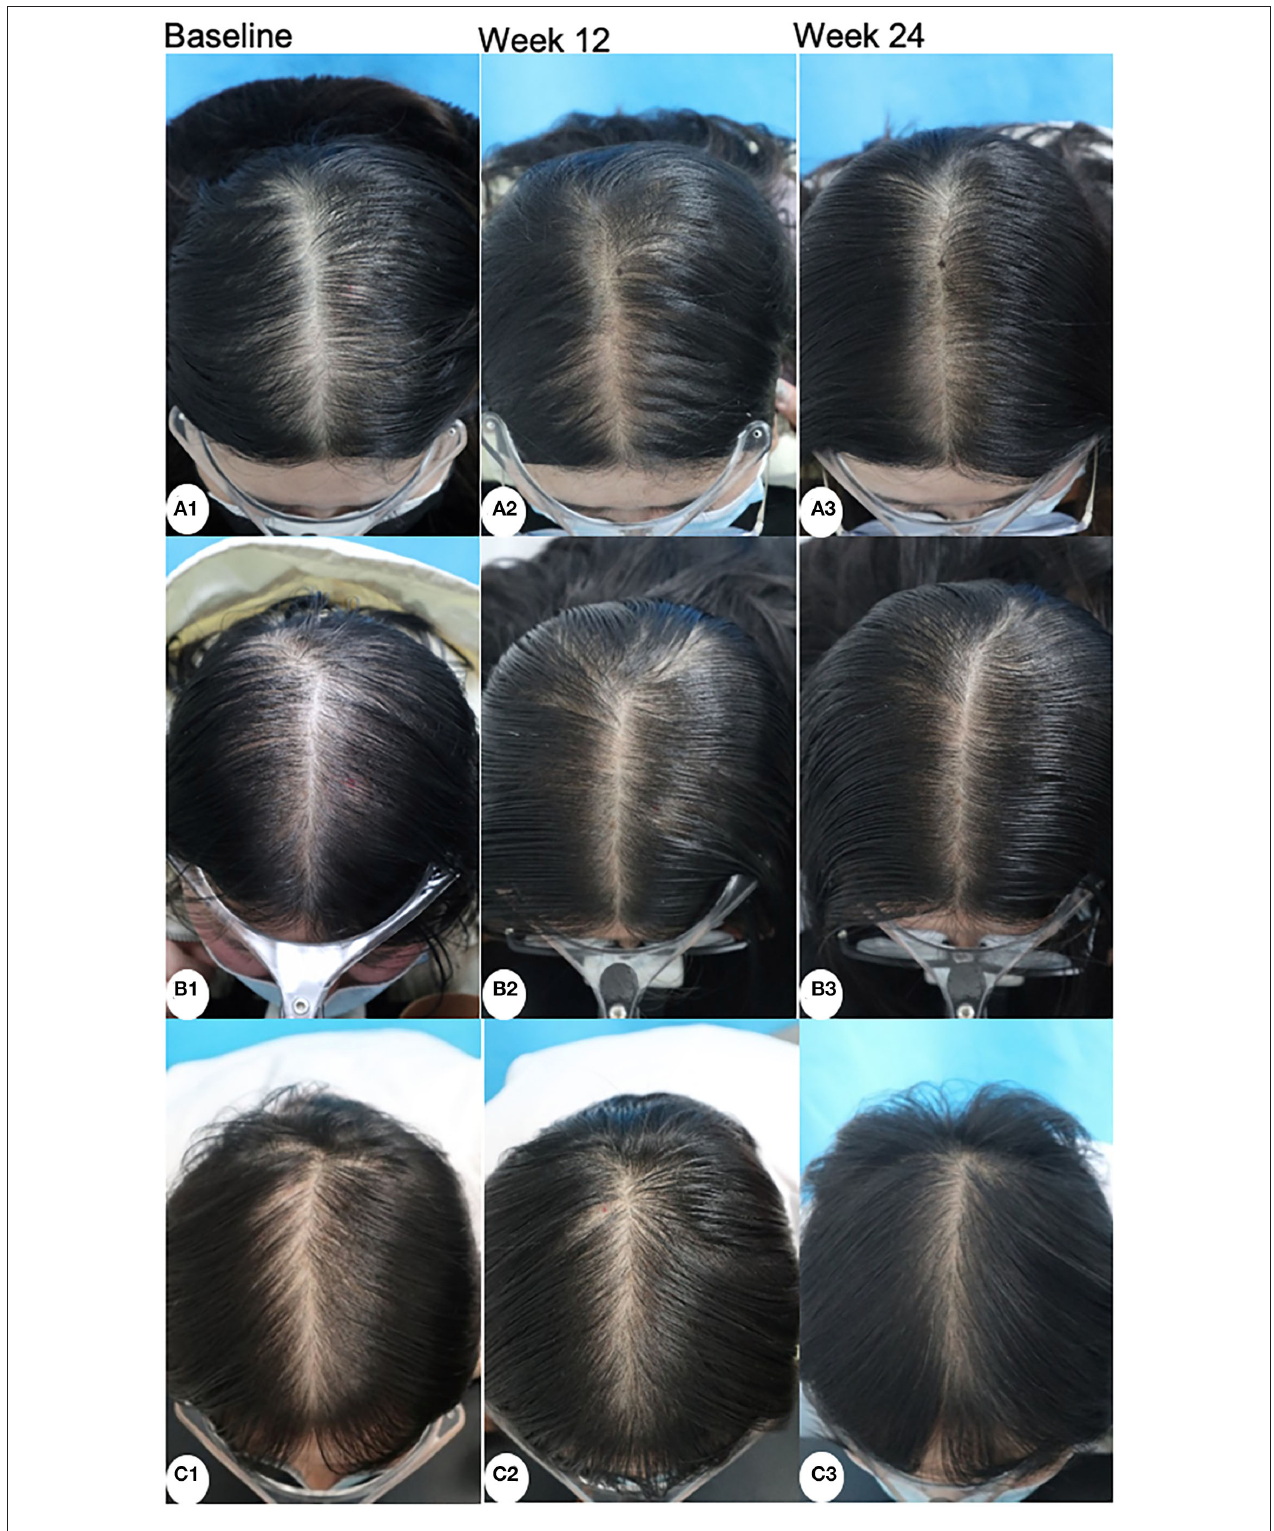
FIGURE 5 | Clinical photographs of patients treated with minoxidil (A) , minoxidil plus spironolactone (B) , and minoxidil plus microneedling (C) at baseline, week 12, and week 24.